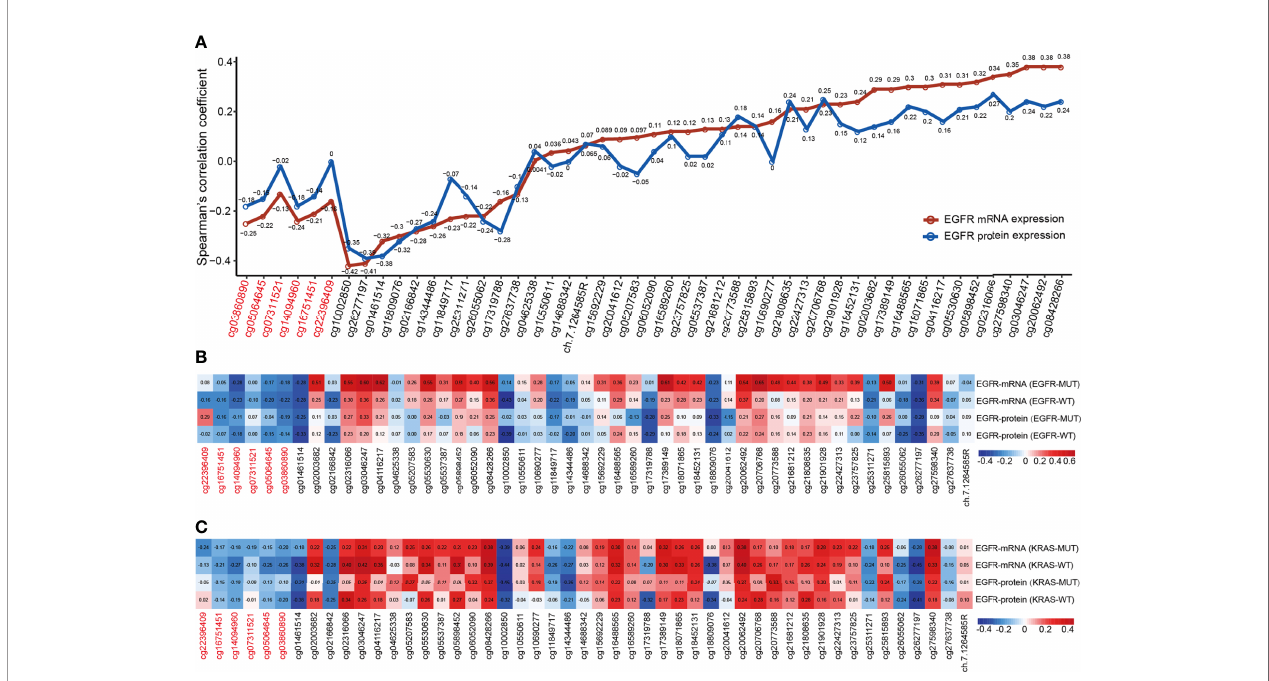
FIGURE 4 | The correlation of EGFR CpG sites methylation and mRNA and protein expression of EGFR in LUAD. (A) Correlation analysis between DNA methylation levels of 49 EGFR CpG sites and mRNA and protein expression of EGFR in the TCGA LUAD cohort. (B, C) Correlation analysis between DNA methylation levels of 49 EGFR CpG sites and mRNA and protein expression of EGFR in EGFR and KRAS status groups of TCGA LUAD cohort. CpG sites labeled in red are located in the EGFR promoter region and in black in the gene body